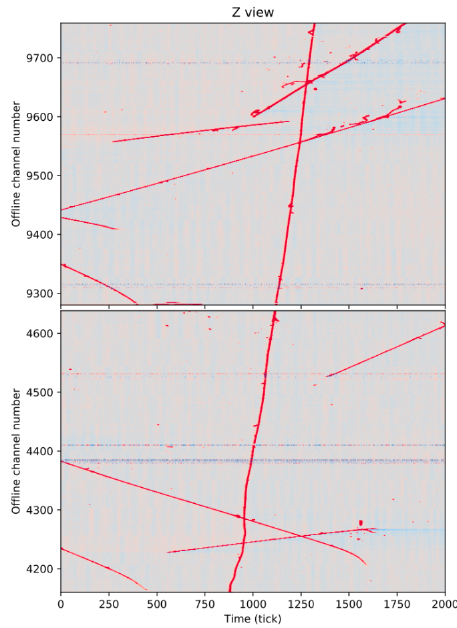
Figure 4. An example of a self-triggered event: a muon parallel to the face of the APA. The extracted window is centered around the timestamp that is contained in the trigger request.